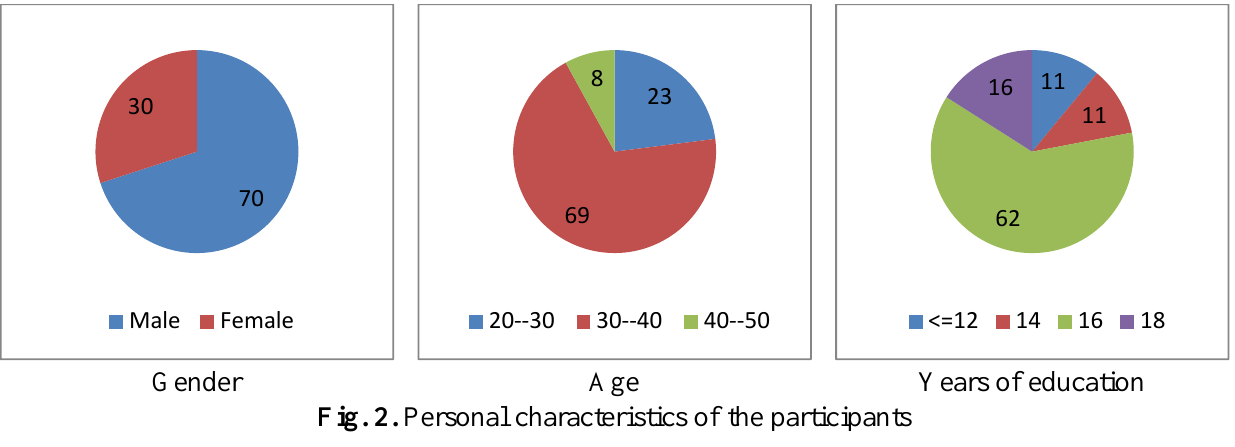
Fig. 2. Personal characteristics of the participants